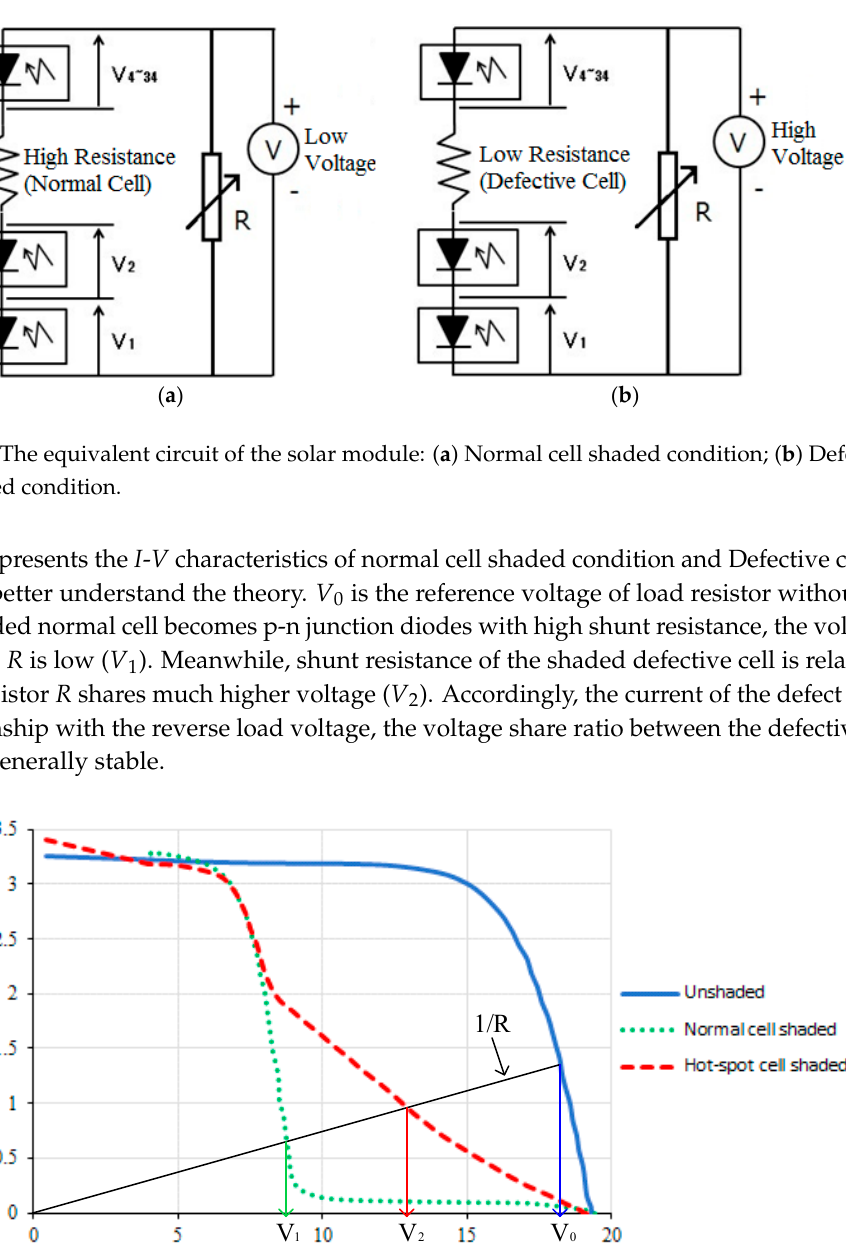
( b ) Figure 7. ( a ) Module constitution; ( b ) Layout of experimental PV string. Table 1. PV solar module specifications. Item